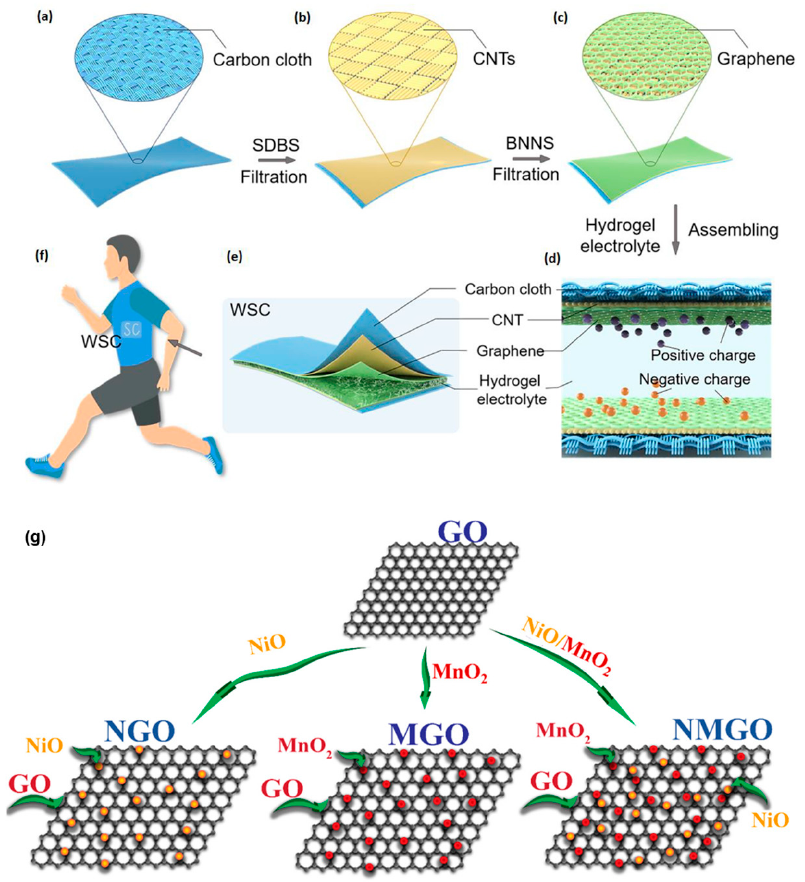
Figure 3. A schematic showing the fabrication process and structure of the wearable supercapacitor (WSC). ( a ) The carbon cloth was used as a current collector. ( b ) The CNTs were loaded on the carbon cloth through filtration, where sodium dodecylbenzene sulfonate (SDBS) was used as a dispersant. ( c ) The graphene was mounted on the CNTs layer through filtration, where boron nitride nanosheets (BNNS) were used to prevent graphene from collapsing. ( d ) The as-fabricated WSC was assembled with hydrogel used as a solid electrolyte. ( e ) The schematic structure of the WSC. ( f ) The WSCs could be integrated into clothing to power wearable devices. Reproduced from ref. [10] under the Creative Commons Attribution 4.0 International (CC BY 4.0) License). ( g ) Schematic illustration for the formation of composites. Reproduced from ref. [1] under the Creative Commons Attribution